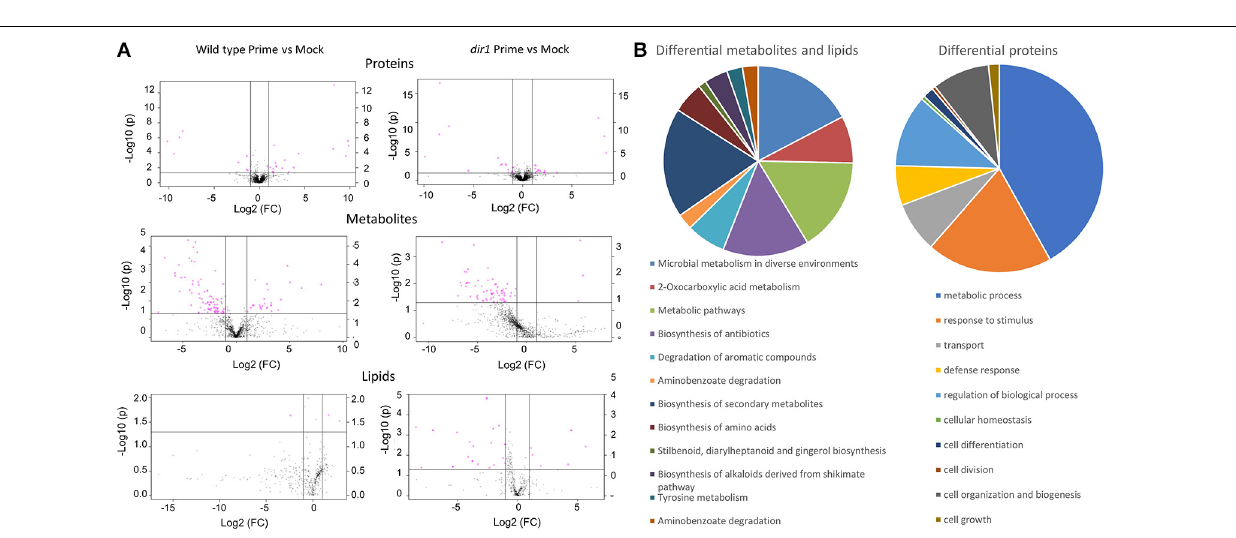
FIGURE 3 | Evaluation of KEGG pathway coverage, data quality, and performance improvement with the 3-in-1 extraction method. (A) Enhanced coverage of specific molecular pathways by the identified proteins, metabolites, and lipids. In The red-colored boxes represent identified proteins and the red-colored circles are lipids and metabolites. (B) Mapping of the quantified proteins, metabolites, and lipids onto the KEGG metabolic pathways. (C) Principal component analysis (PCA) of relative levels of proteins, metabolites, and lipids obtained from three biological replicates under the four experimental conditions (WM, wild type mock; WP, wild type primed; dM, dir1 mock; dP, dir1 primed).